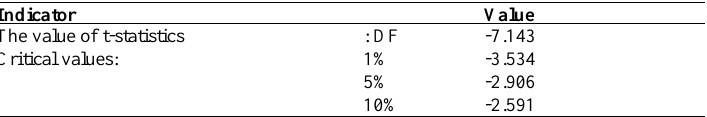
Table 2. Estimations of the non-stationarity of the first differences of the series ln (D) by the DF test